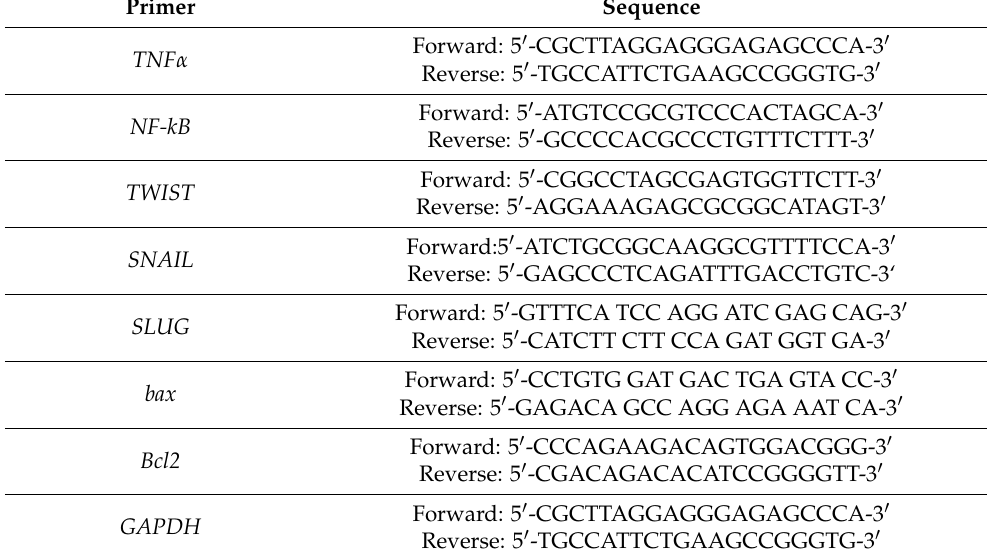
Table 1. Sequences of the